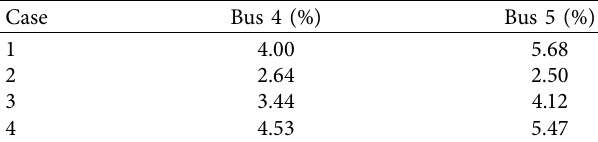
Table 3: Total harmonic distortion